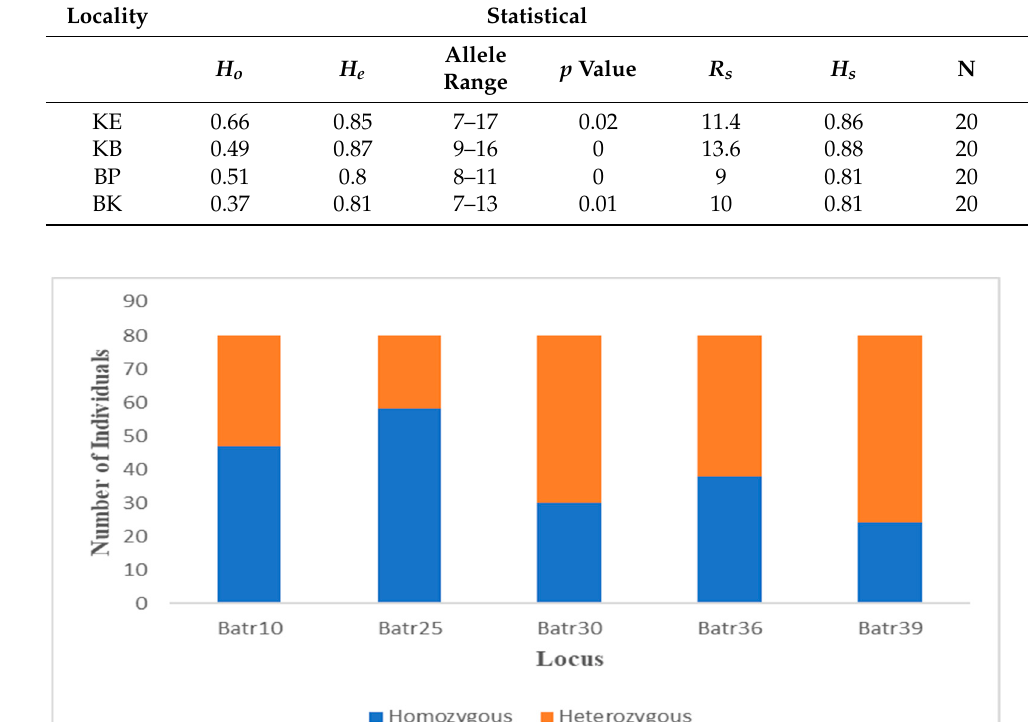
Table 1. Descriptive statistics for each population including a range of alleles, expected heterozygosity ( H e ), and observed heterozygosity ( H 0 ), allele richness ( R s ), gene diversity ( H s ), sample size (N). Locality H o H e